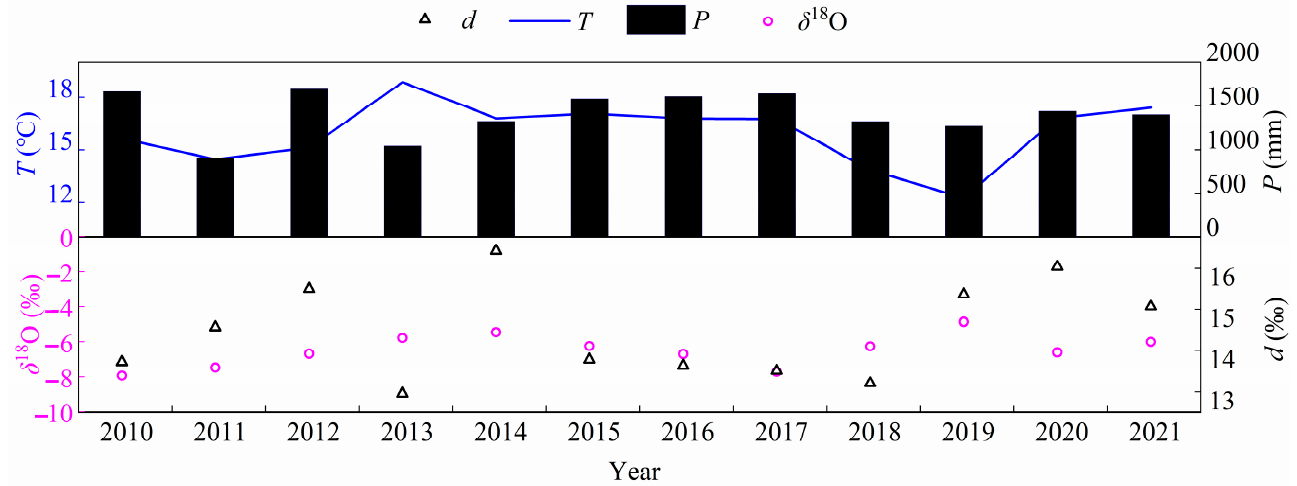
Figure 4. Temporal variations in annual temperature ( T ), precipitation ( P ), δ 18 O p and d-excess ( d ) in Changsha. in